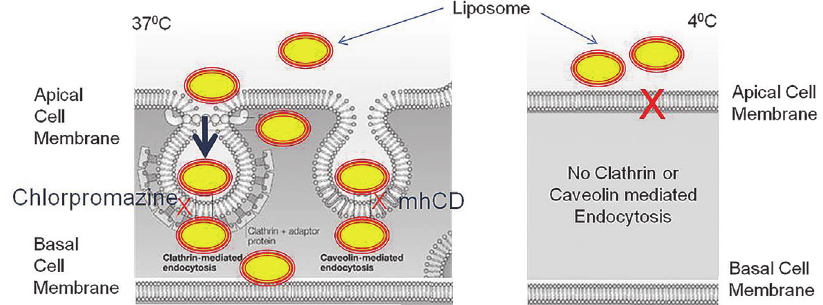
Fig 5. Illustration depict temperature dependent endocytoic uptake of liposome encapsulated gold (Lipo-gold). The cellular process of clathrin and caveolin mediated endocytosis are energy dependent and therefore only occur at 37°C and are inhibited at 4°C. Compared to mhCD, chlorpomazine was more efficient in blocking endocytosis of liposomes, which indicates a predominance of clathrin mediated endocytosis as a mechanism of